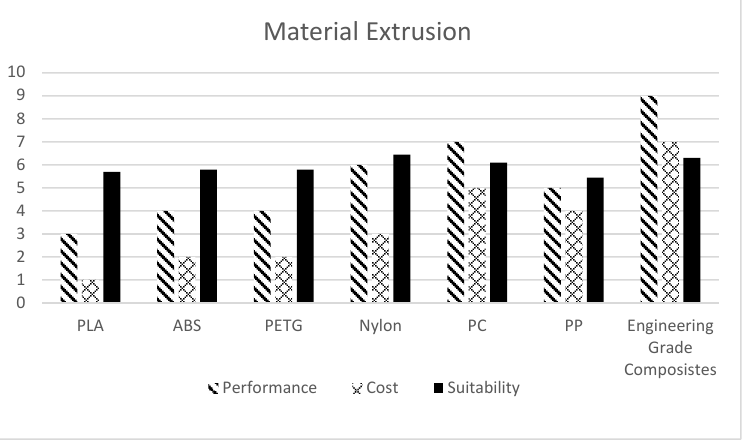
Figure 11. Comparison of various materials available for Material Extrusion AM Process.